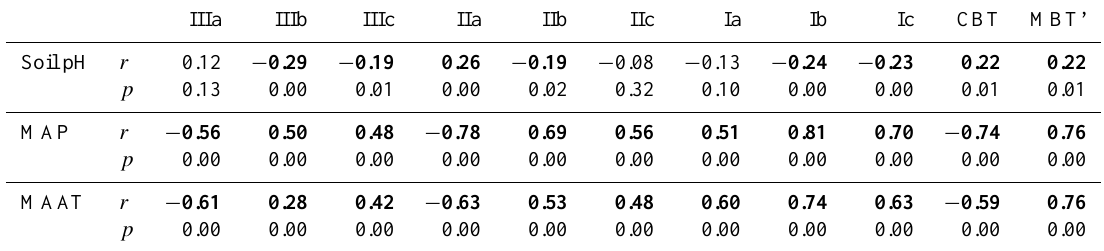
Table 1. Correlations between the distribution of bGDGTs (fractional abundances, CBT and MBT’) and environmental variables (MAAT, MAP and soil pH) for the Chinese alkaline soils ( n = 165) compiled in Yang et al. (2014a) and this study, with significant correlations ( p <0.05) indicated in